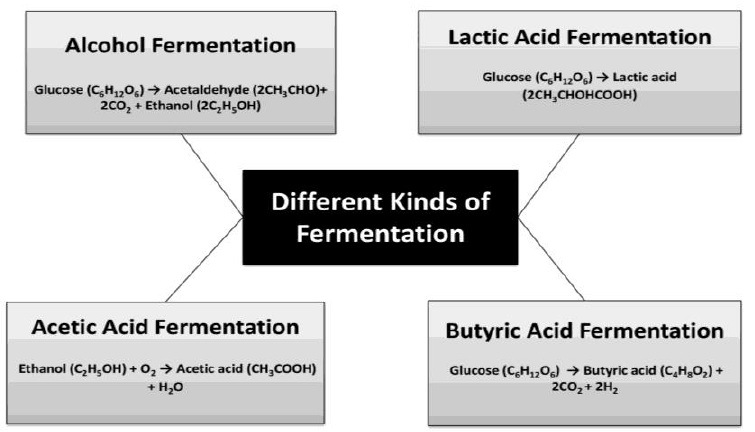
Figure 3. Different types of Fermentation on the basis of the end product formed.